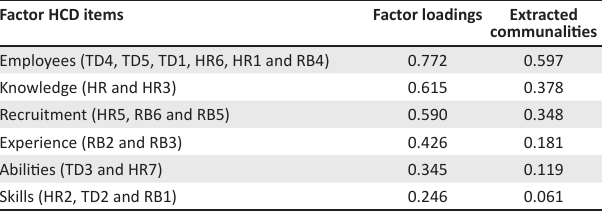
Extraction method: Principal axis factoring. TABLE 8: Factor loadings and extracted communalities for human capital disclosure. Factor HCD items